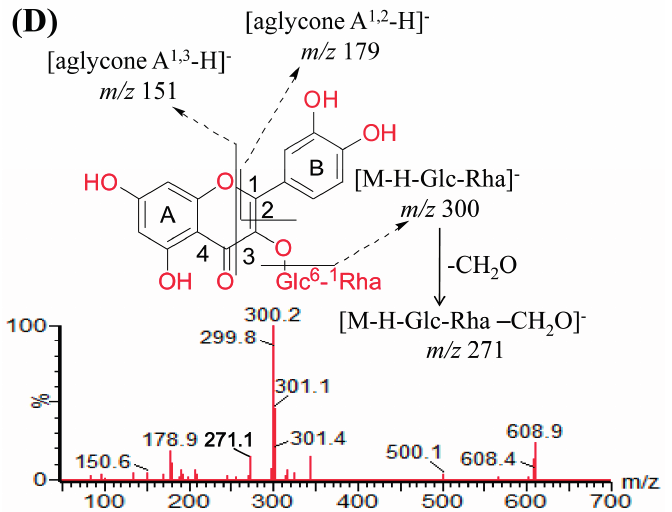
Figure 2. The ESI-MS/MS spectra and the proposed fragmentation pathway of chlorogenic acid ( A ); swertiamarin ( B ); schaftoside ( C ); and rutin ( D ).